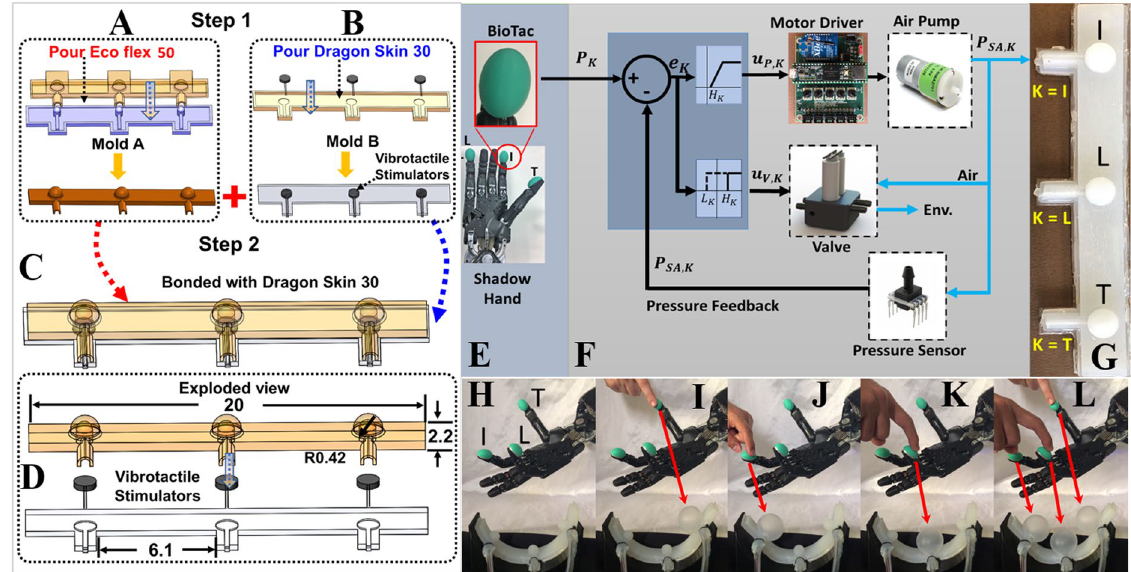
Figure 7. Soft robotic armband: manufacturing and control. ( A ) The upper and foundation molds are mated to manufacture the actuation part of the armband. ( B ) The vibrotactile actuators are embedded in the base. ( C ) The actuation and the base parts are bonded together. ( D ) Exploded view showing the armband components, units of cm. ( E ) Shadow Hand and BioTac SPs. ( F ) Soft actuator nonlinear pressure controllers. ( G ) Soft robotic armband where T, L, and I indicate the thumb, little and index fingers, respectively. ( H ) Three BioTac SPs attached to the Shadow Hand are shown at rest. Note the deflated state of all three air chambers on the armband (placed below the hand for illustrative purposes). ( I ) Applying pressure to the thumb ( J ) index, and ( K ) little fingertips individually or ( L ) simultaneously resulted in proportionally scaled pressures within the soft robotic armband actuators, implemented by each of the three nonlinear